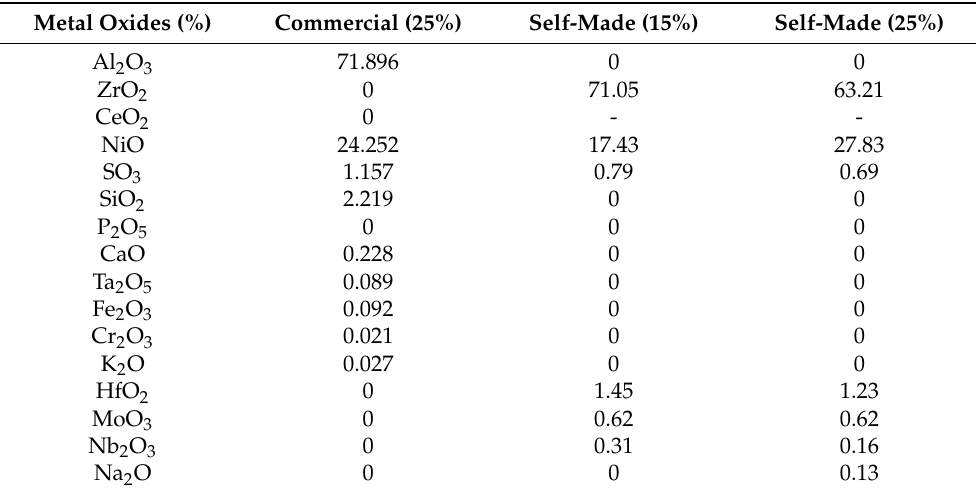
Table 3. XRF characterization results of Ni-based